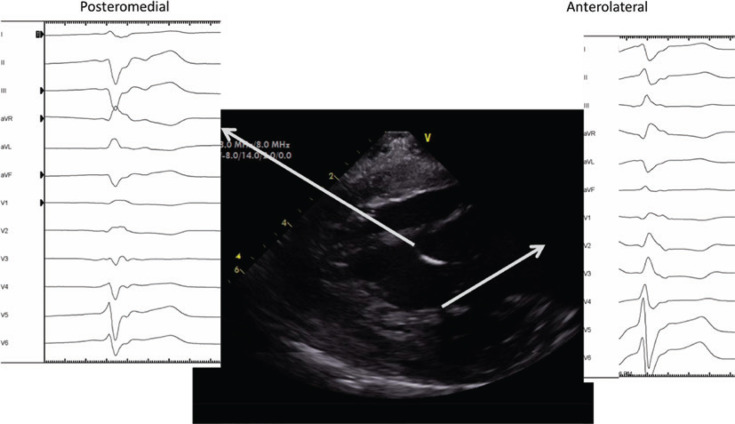
Intracardiac echocardiography anatomic correlation of posteromedial and anterolateral premature ventricular depolarizations.